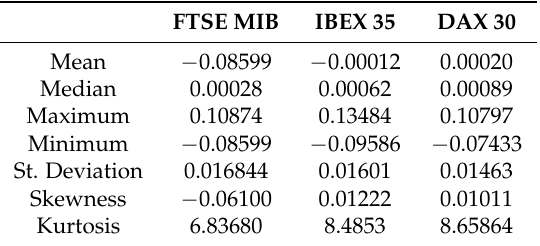
Table 1. Descriptive statistics of the three stock indexes, FTSE (Financial Times Stock Exchange)